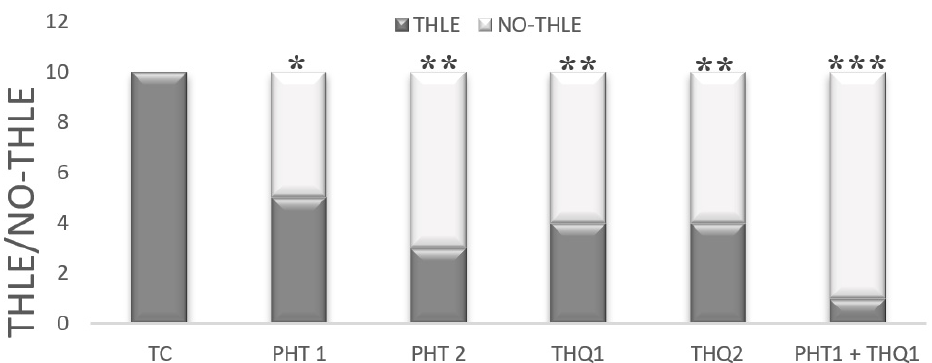
Figure 1. Effect of PHT (20 and 40 mg/kg), THQ (40 and 80 mg/kg) and PHT (20 mg/kg) + THQ (40 mg/kg) against MES-produced THLE in rats. Fischer’s exact test (one tailed) was used to compare the ratio of THLE/NO THLE. All groups were compared with the TC group. PHT, THQ, TC, MES and THLE indicate phenytoin, thymoquinone, toxic control, maximal electric shock and tonic hind limb extension, respectively. * p < 0.01, ** p < 0.05, *** p < 0.001